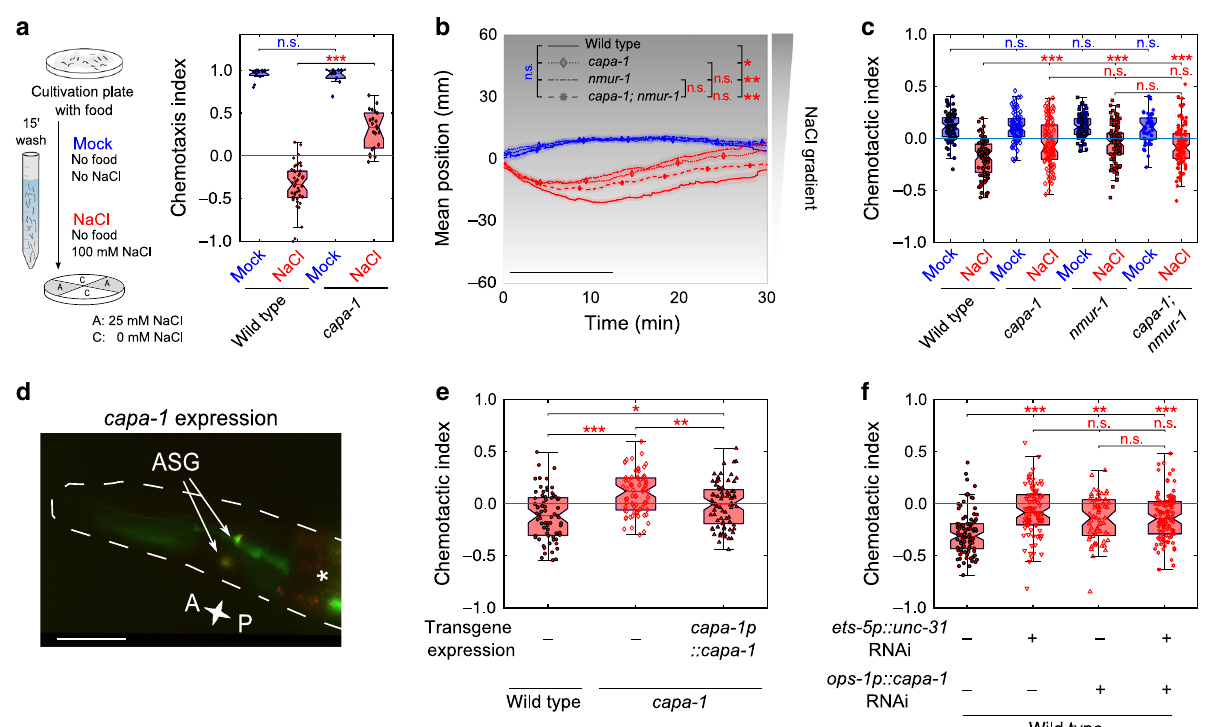
Fig. 5 CAPA-1 NMU-like neuropeptides signal from ASG neurons to promote gustatory aversive learning through NMUR-1. a Gustatory aversive learning behavior of capa-1 (ok3065) mutant animals in the quadrant chemotaxis assay. From left to right n = 13, 47, 10, 22 experimental repeats. b Mean position on a 0 – 100 mM NaCl gradient through time and c the corresponding chemotactic indices of capa-1 (ok3065) , nmur-1 (Ist1672) and capa-1 (ok3065); nmur-1 (Ist1672) double mutants after mock- and NaCl-conditioning. Black bar indicates the time interval for calculating the mean gradient position and the chemotactic index, but also the biased random walk and klinotaxis indices shown in Supplementary Fig. 7b. From left to right n = 79, 89, 79, 98, 83, 100, 48, 101 animals per genotype. d Co-localization of a bicistronic GFP construct harboring the promoter, genomic DNA and 3 ′ UTR of the capa-1 gene (capa-